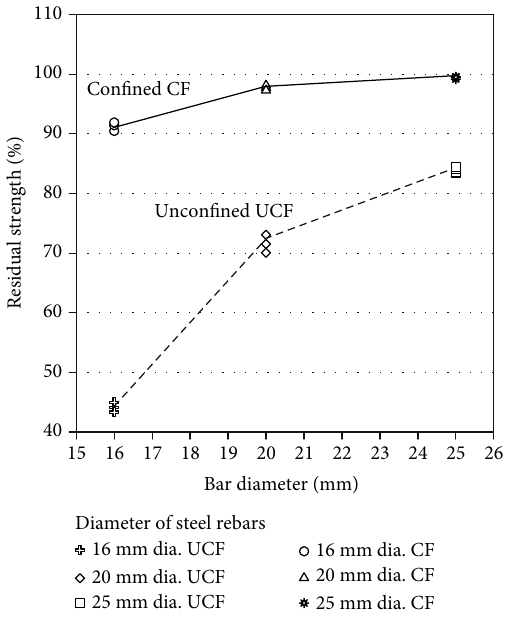
Figure 13: Correlation of bar diameter and residual